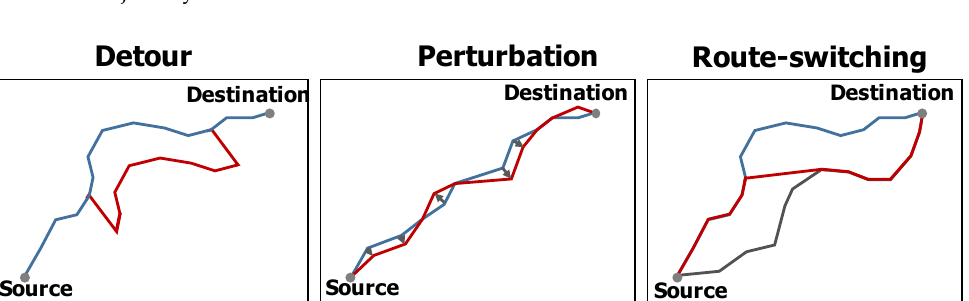
Figure 6. Models for different injected outlier types. ( Left ) Detour: a sub-trajectory was replaced with another sub-trajectory (red). ( Middle ) Perturbation: randomly selected points (red) were moved from their original places. ( Right ) Route-switching: two sub-trajectories (red) from two different trajectories were connected as an outlier trajectory.